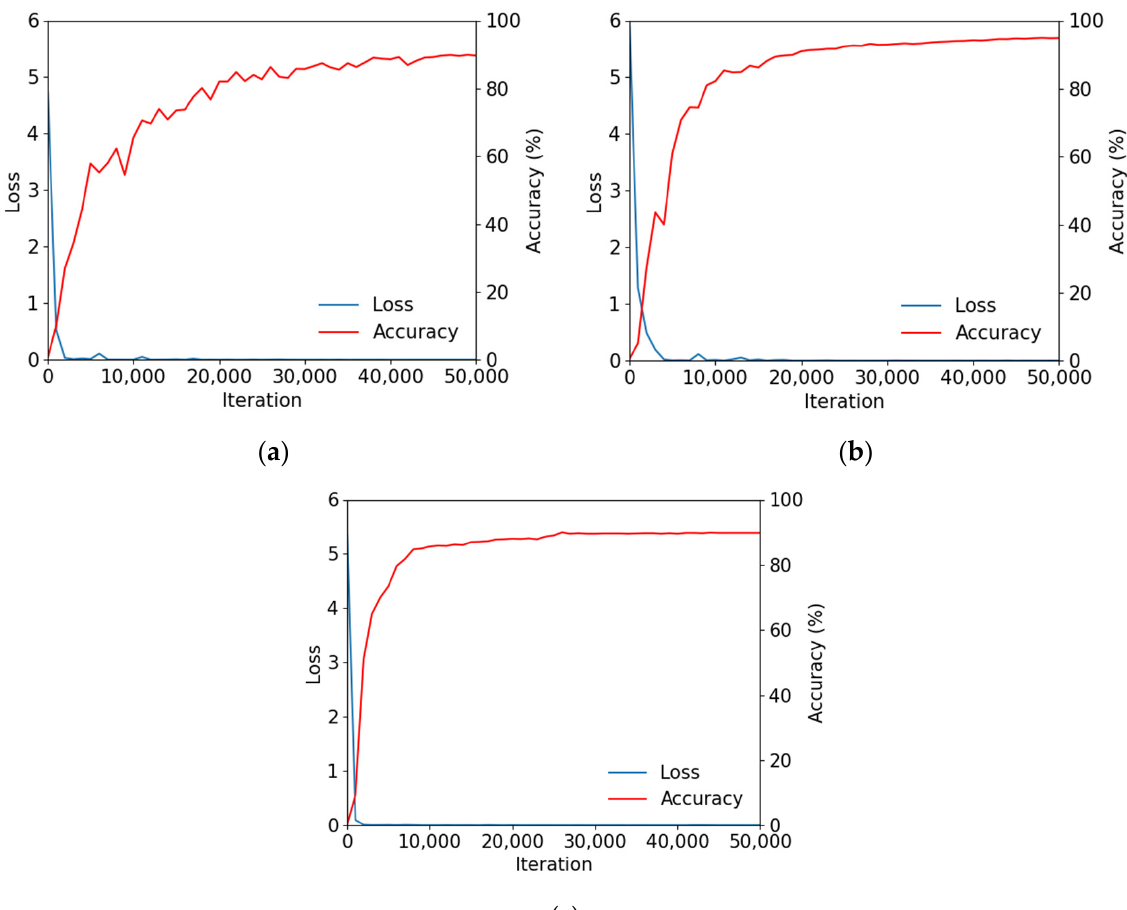
Figure 4. Graphs of training loss and accuracy by ResNet-101 with ( a ) CASIA-Iris-Distance, ( b ) CASIA-Iris-Lamp, and ( c ) IIT Delhi iris databases.